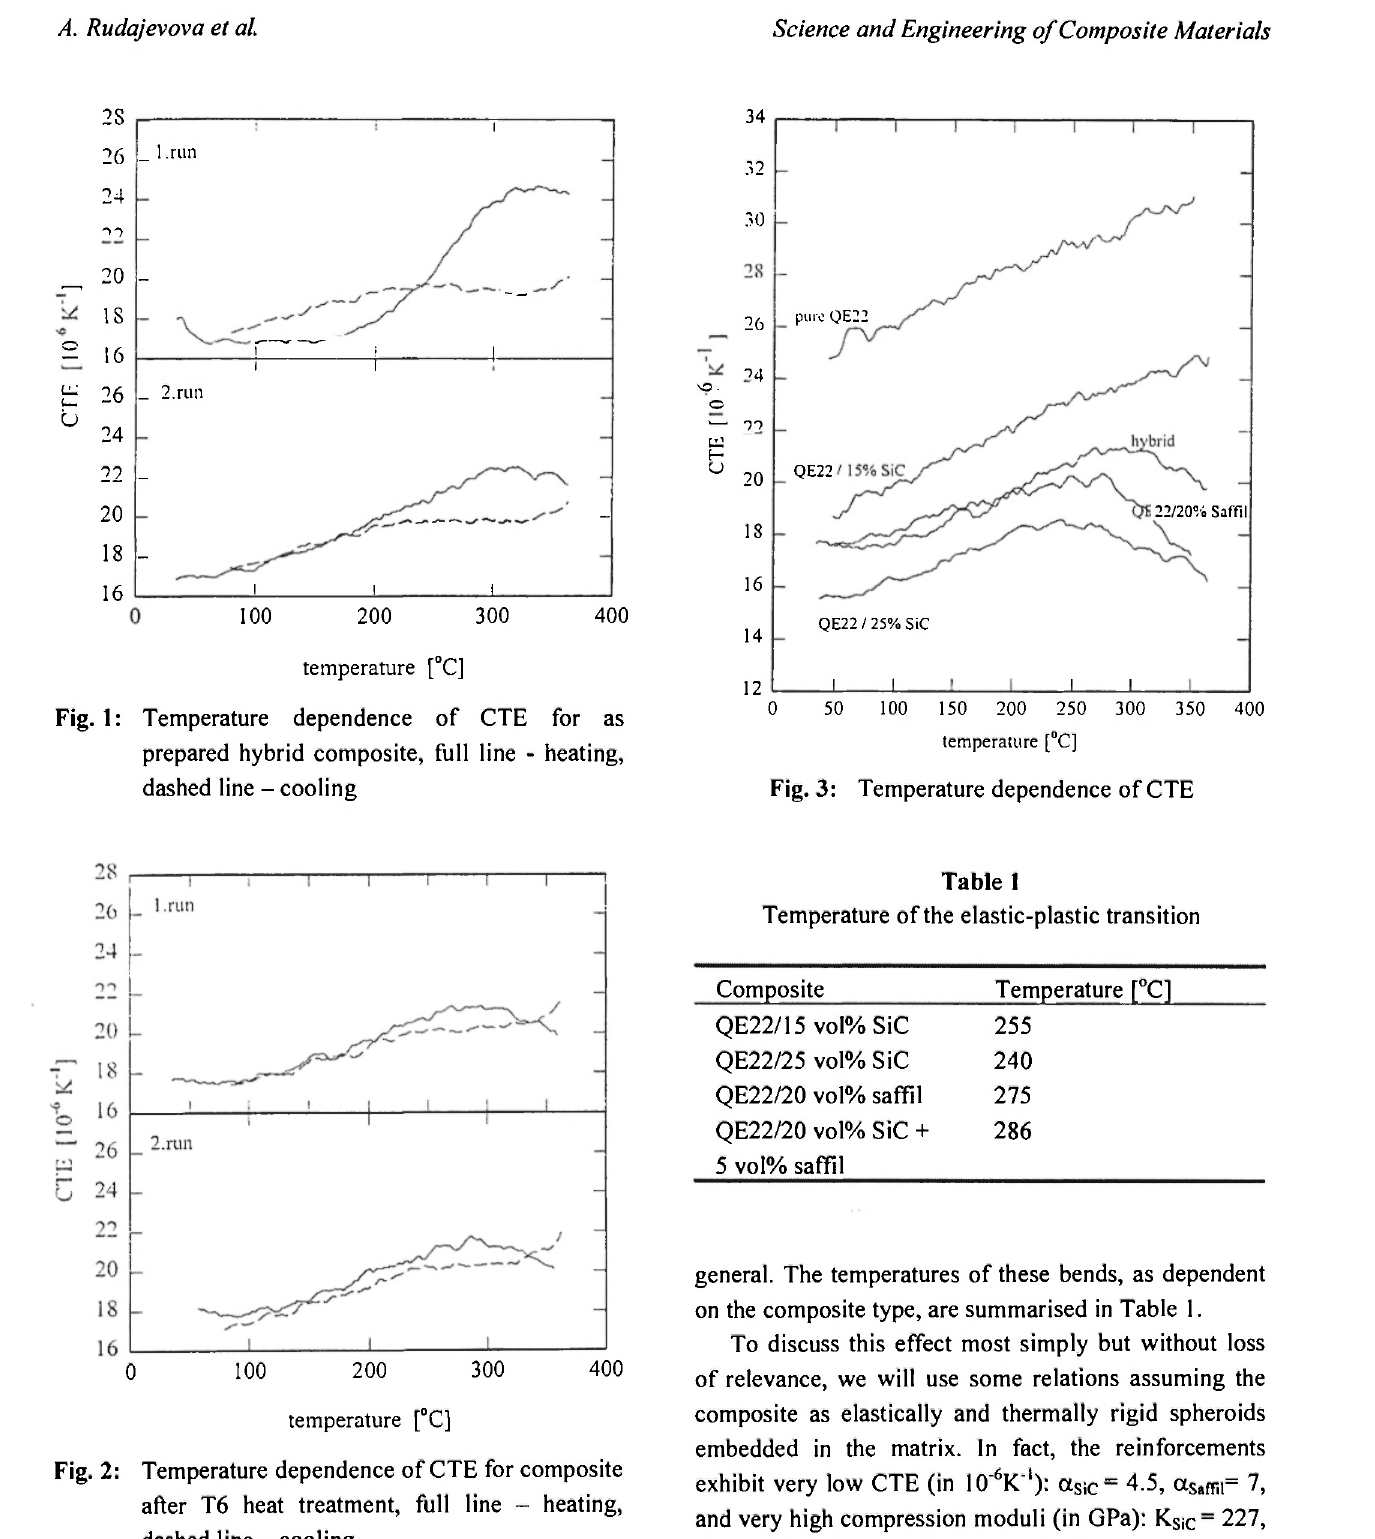
and very high compression moduli (in GPa): K S ic = 227, KMg-alloys